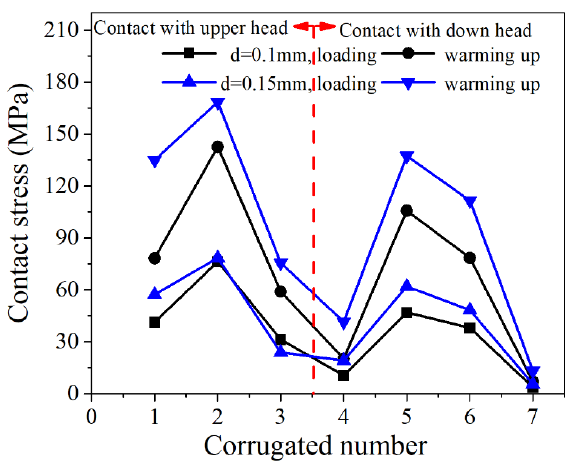
Figure 10. Stress in the contact area of corrugated gasket under different loading displacement when the plate thickness is 0.3 mm.